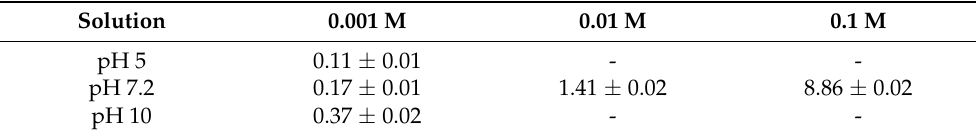
Figure 1. Speciation diagram of phosphate species in solution as a function of pH. The dotted lines represent the studied pH values (5, 7.2 and 10). Table 1. Initial conductivity values of the working solutions (in mS cm − 1